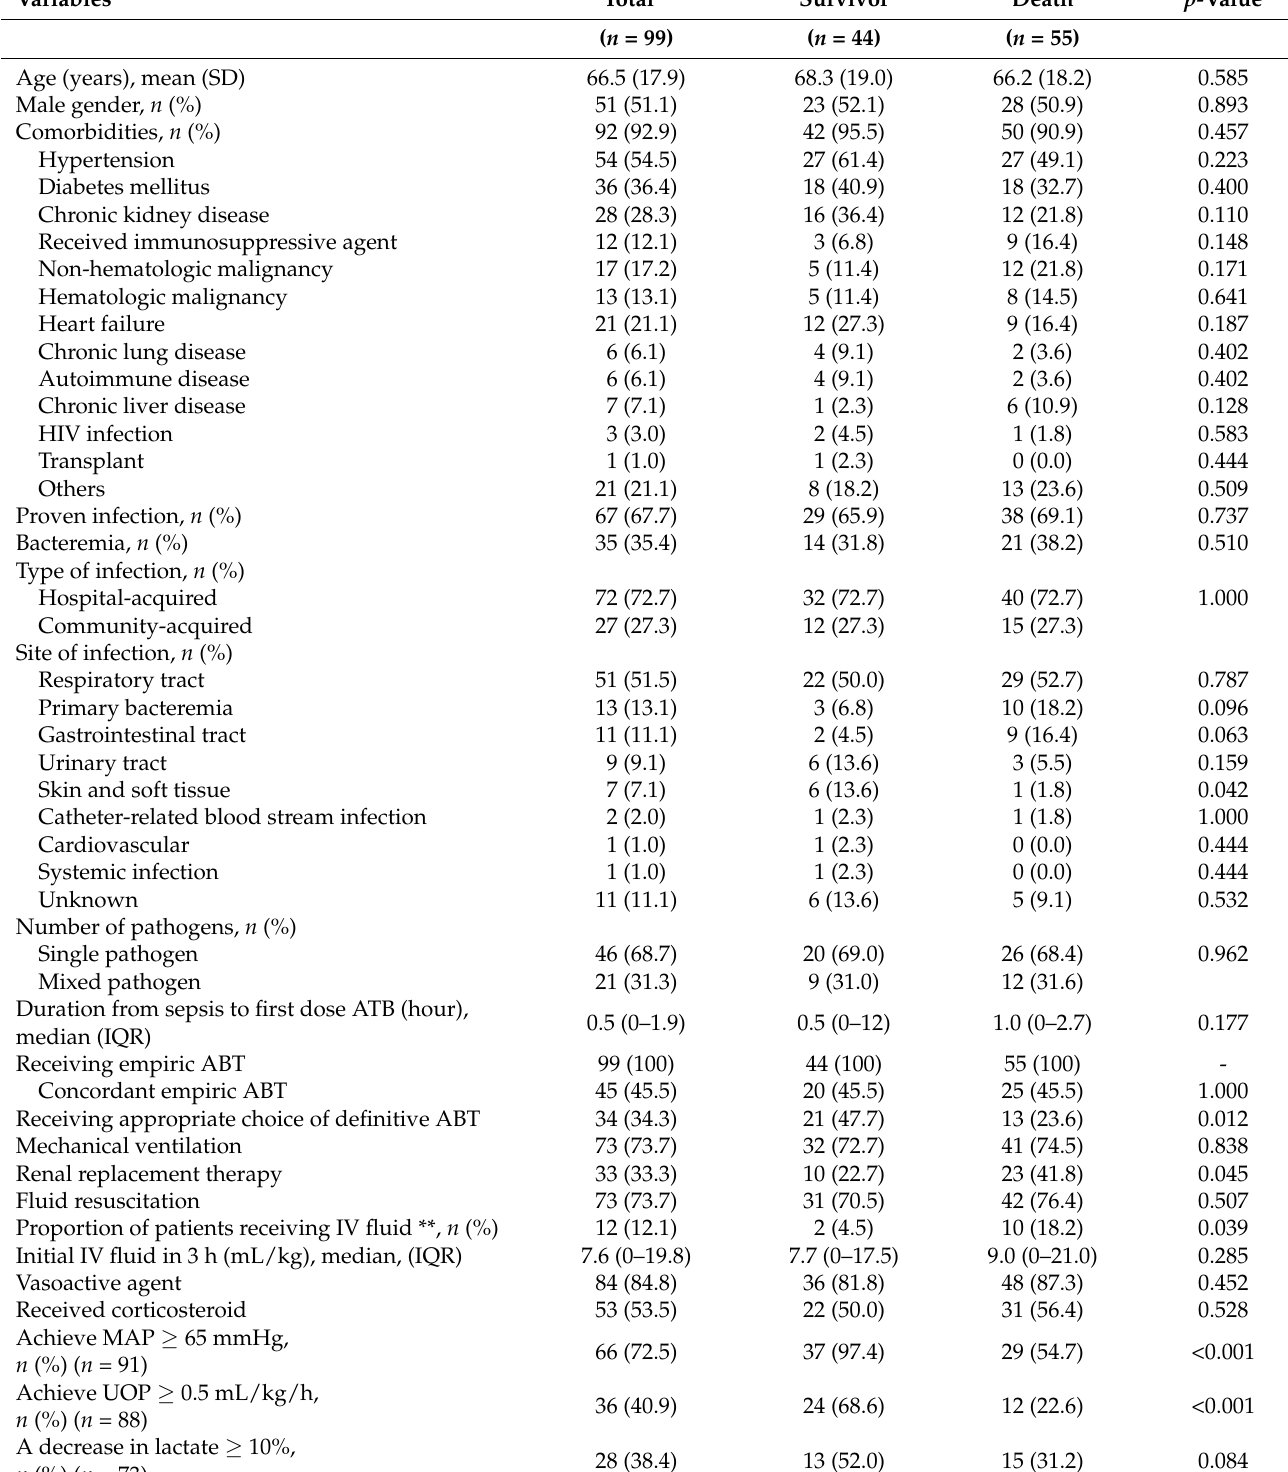
Table 3. Characteristics of all patients with septic shock, and a comparison between those who survived and those who died within 28